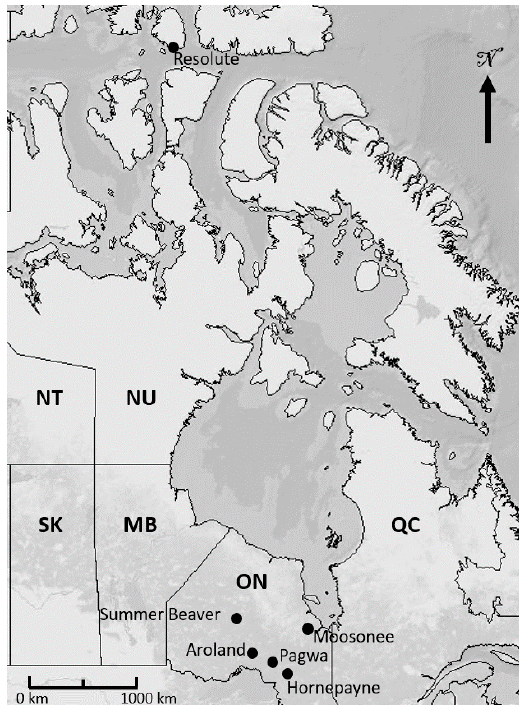
Figure 1. Map showing Resolute in Nunavut (NU) and regions of interest in Ontario (ON).